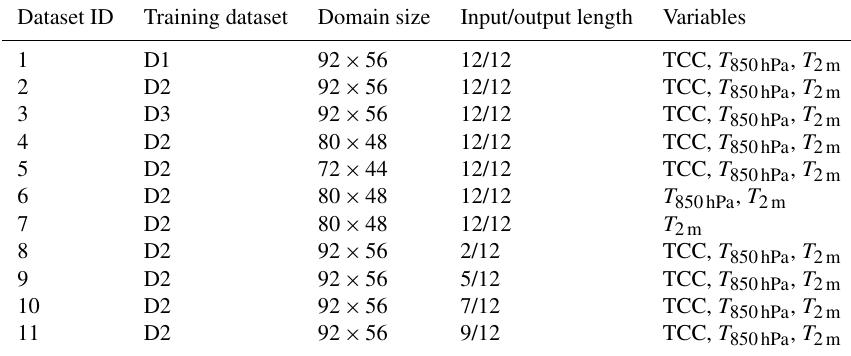
Table A1. Overview of the datasets used in this study.